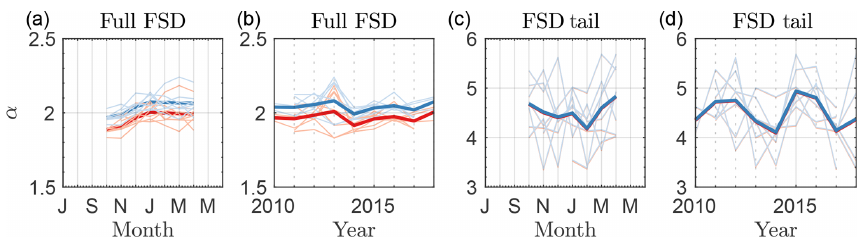
Figure 5. Top row: Temporal variability of power-law fits to Arctic FCDs. (a) Estimate of the most likely power-law scaling coefficient for all recorded floe chords as a function of month over all years, calculated from the MLE method Eq. (14) (red lines) or Eq. (13) (blue lines). Thick lines are climatological averages, and thin lines are individual years. Plot is centered on 1 January. (b) Like (a) , but plotted for individual years over all months. Thick lines are the average over months plotted in (b) and thin lines are individual months in each year. (c–d) Same as (a–b) , but for the distributional tail starting from D ∗ computed using the MLE method. “Arctic” refers to points above 60 ◦